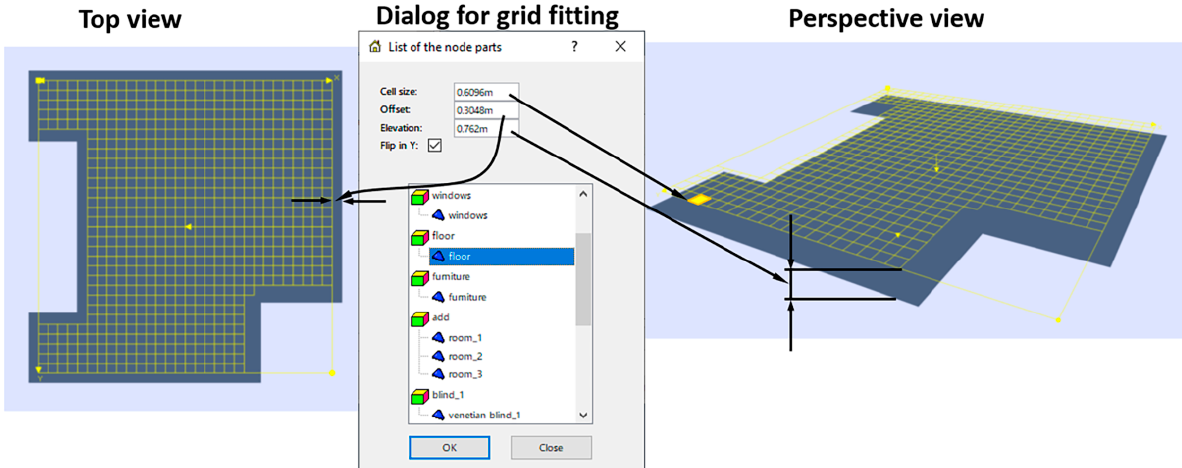
Figure 1. Generation of the illuminating grid.